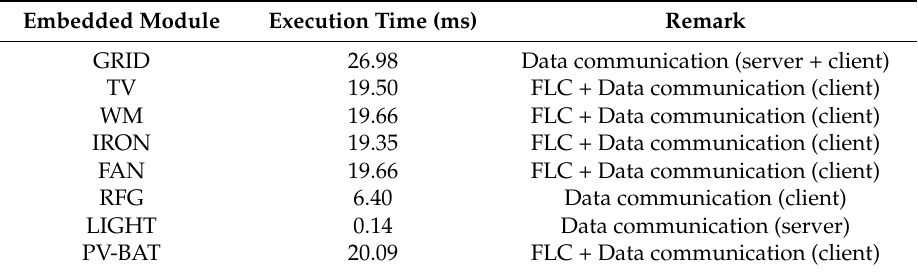
Table 4. Measurement results of the execution